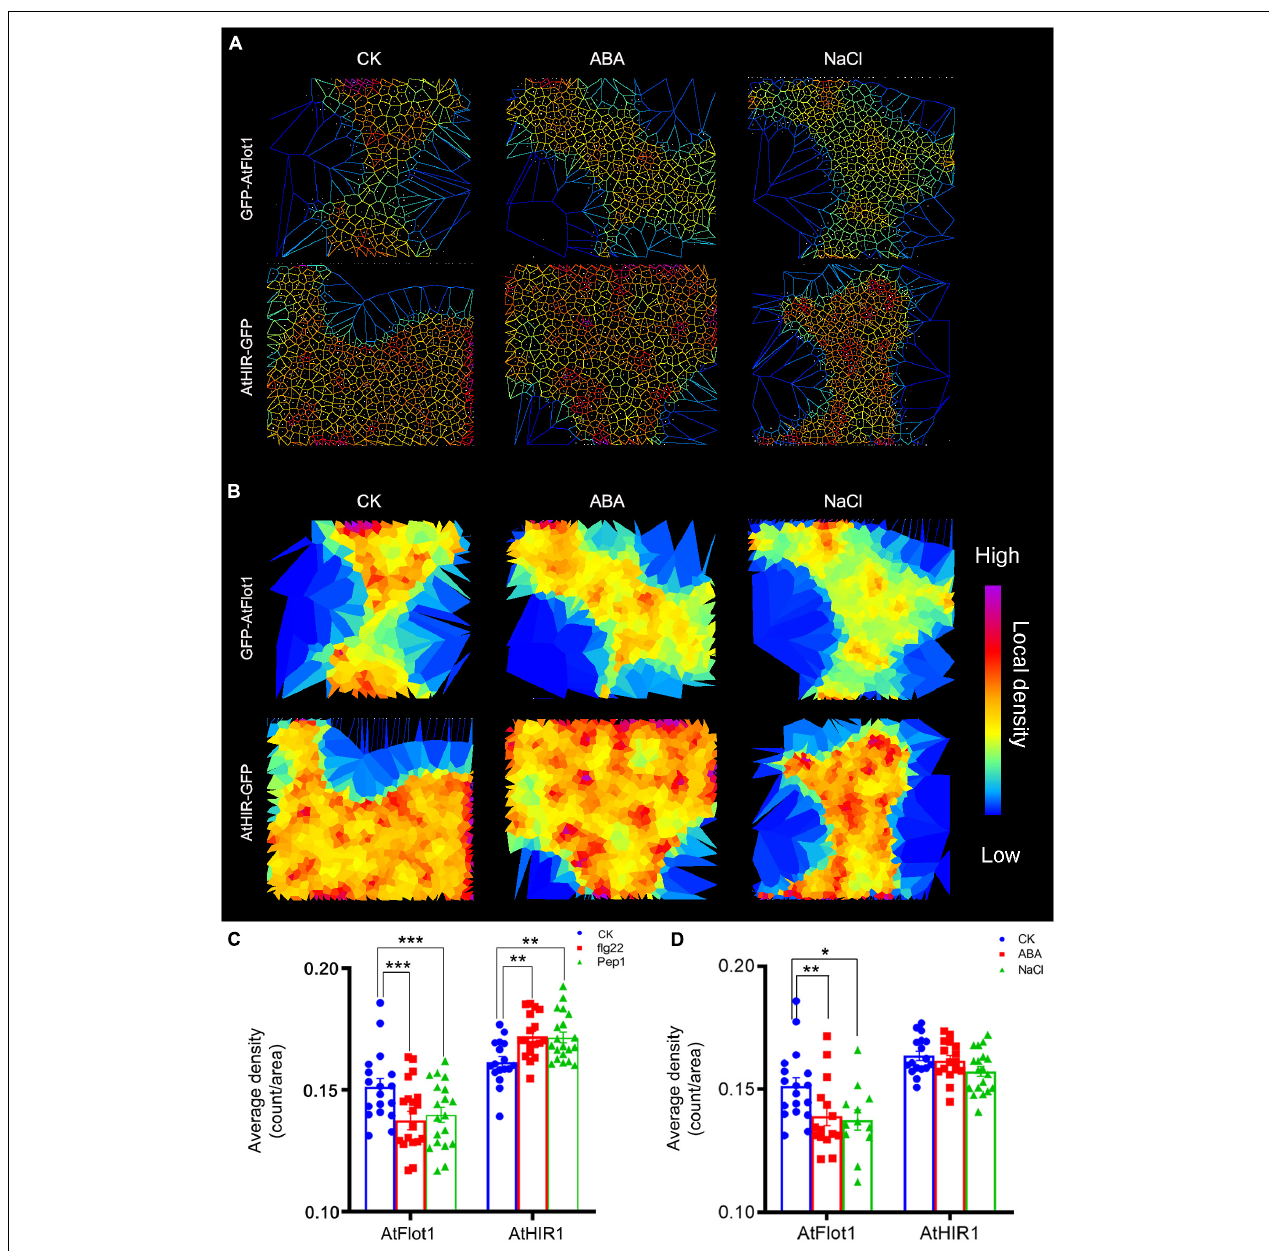
FIGURE 5 | Density of GFP-AtFlot1 and AtHIR1-GFP at the PM under biotic and abiotic stresses. (A,B) Cell identification and segmentation in a multicellular raw image. Recognition and segmentation of cells in PM by Imaris software based on protein density and Voronoï tessellation setting of the threshold of localization density. (C) The fluorescence density of GFP-AtFlot1 and AtHIR1-GFP at the PM in leaf epidermal cells under control and flg22 and Pep1 treatment conditions. For each examination, at least 20 cells from each of five seedlings were examined. In each case, three biological replicates were performed. Statistical significance was determined using Student’s t -tests (** P < 0.01 and *** P < 0.001). (D) The fluorescence density of GFP-AtFlot1 and AtHIR1-GFP at the PM in leaf epidermal cells treated with ABA and NaCl. For each examination, at least 30 cells from each of five seedlings were examined. In each case, three biological replicates were performed. Statistical significance was determined using Student’s t -tests (* P < 0.05; ** P < 0.01).